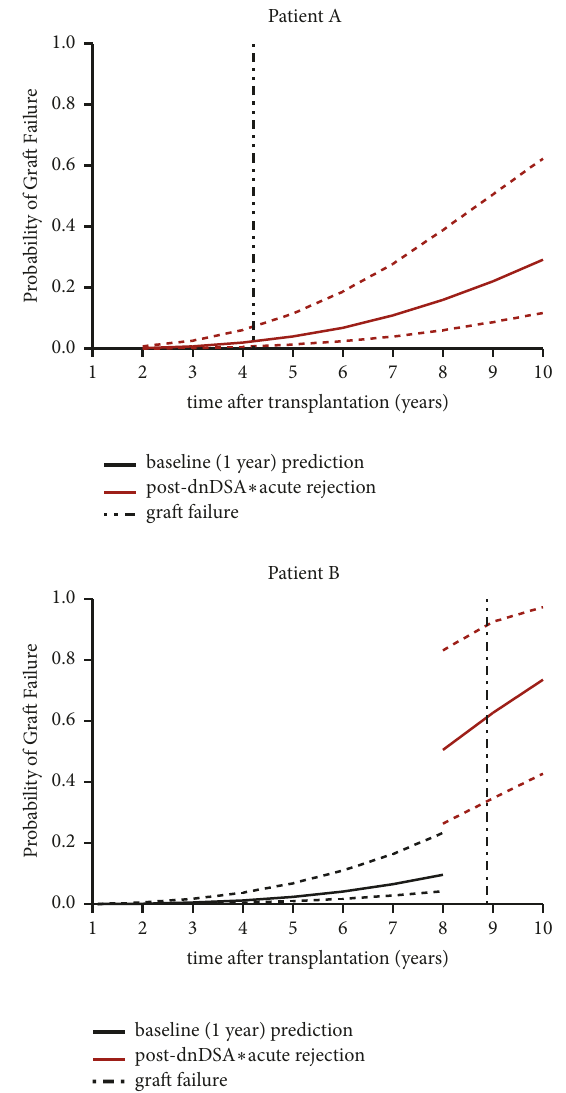
Figure 4: The worst (patient A) and the best (patient B) prediction of probabilities of 10-year graft failure with 95% confidenceintervals from the final joint latent-class mixed model among the group of patients who developed de novo donor-specific anti-HLA antibody ( dn DSA). The black part of the curve corresponds to predictions based on covariates known up to 1 year after transplantation while the red curve corresponds to prediction recalculated after onset of both dn DSA and acute rejection; the vertical dashed black line indicates the time of graft